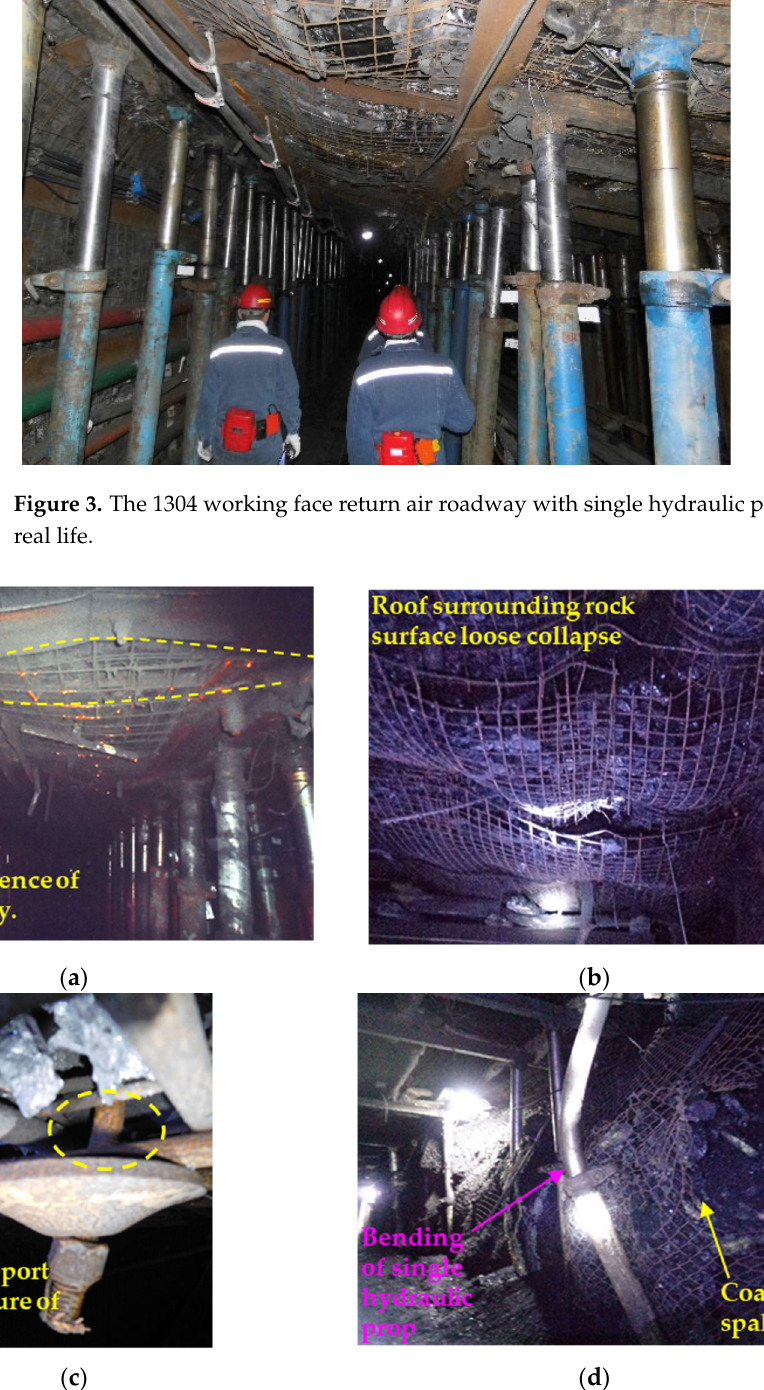
Figure 4. Deformation of the 1304 return airway. ( a ) Roof subsidence of the return airway; ( b ) Roof surrounding rock surface loose collapse; ( c ) Bolt tray is out of roof support failure; ( d ) Coal rib spalling and bending of the single hydraulic prop.